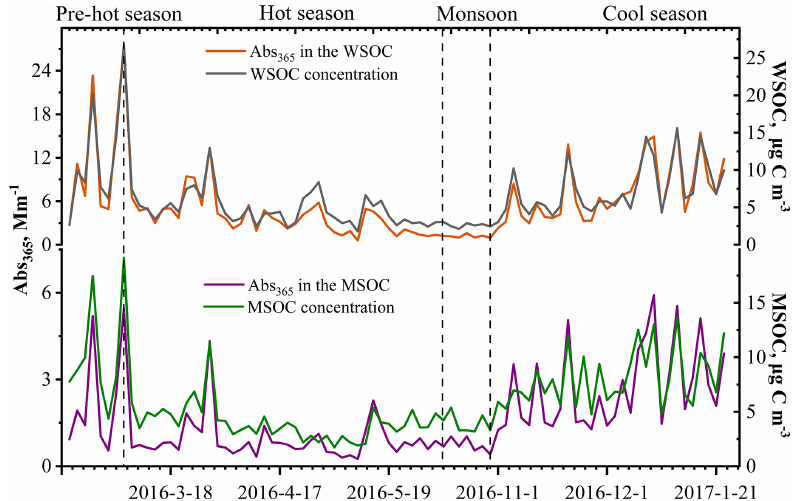
Figure 3. Time series plots of the water-soluble organic carbon (WSOC) and methanol-soluble organic carbon (MSOC) concentration (µgCm − 3 ) as well as the water- and methanol-extract light absorption coefficient at 365nm (Abs 365 ) (Mm − 1 ) in the aerosol samples from Bangkok, Thailand, during 2016–2017.